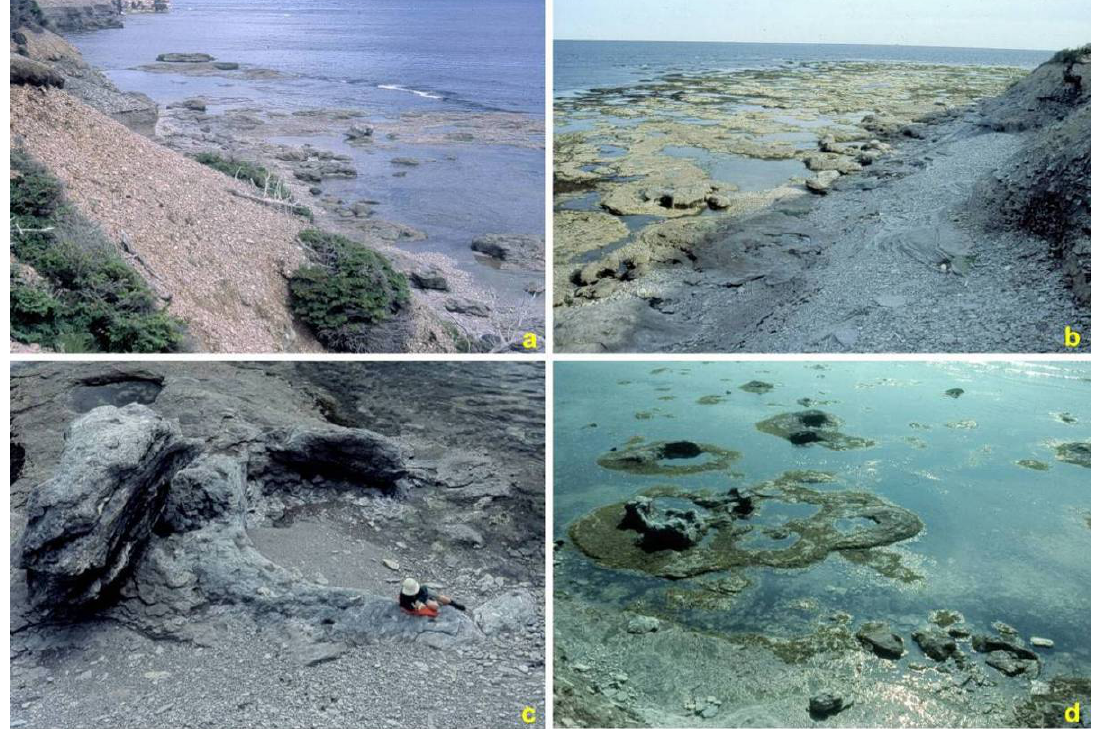
Figure 5. Outcrop views at East Point. ( a ) western panoramic view of the reef swarm on the tidal flats, taken from the bluff top, direction of Goéland Cliffs in the distance; ( b ) East Point reef swarm at low tide direction eastwards near East Point itself; ( c ) panoramic view of a single patch reef ( ca. 30 m in diameter) at low tide (human for scale); ( d ) panoramic view of several irregular to circular patch reef tops at intermediate tide, with reef cores partly eroded on this modern wave-cut